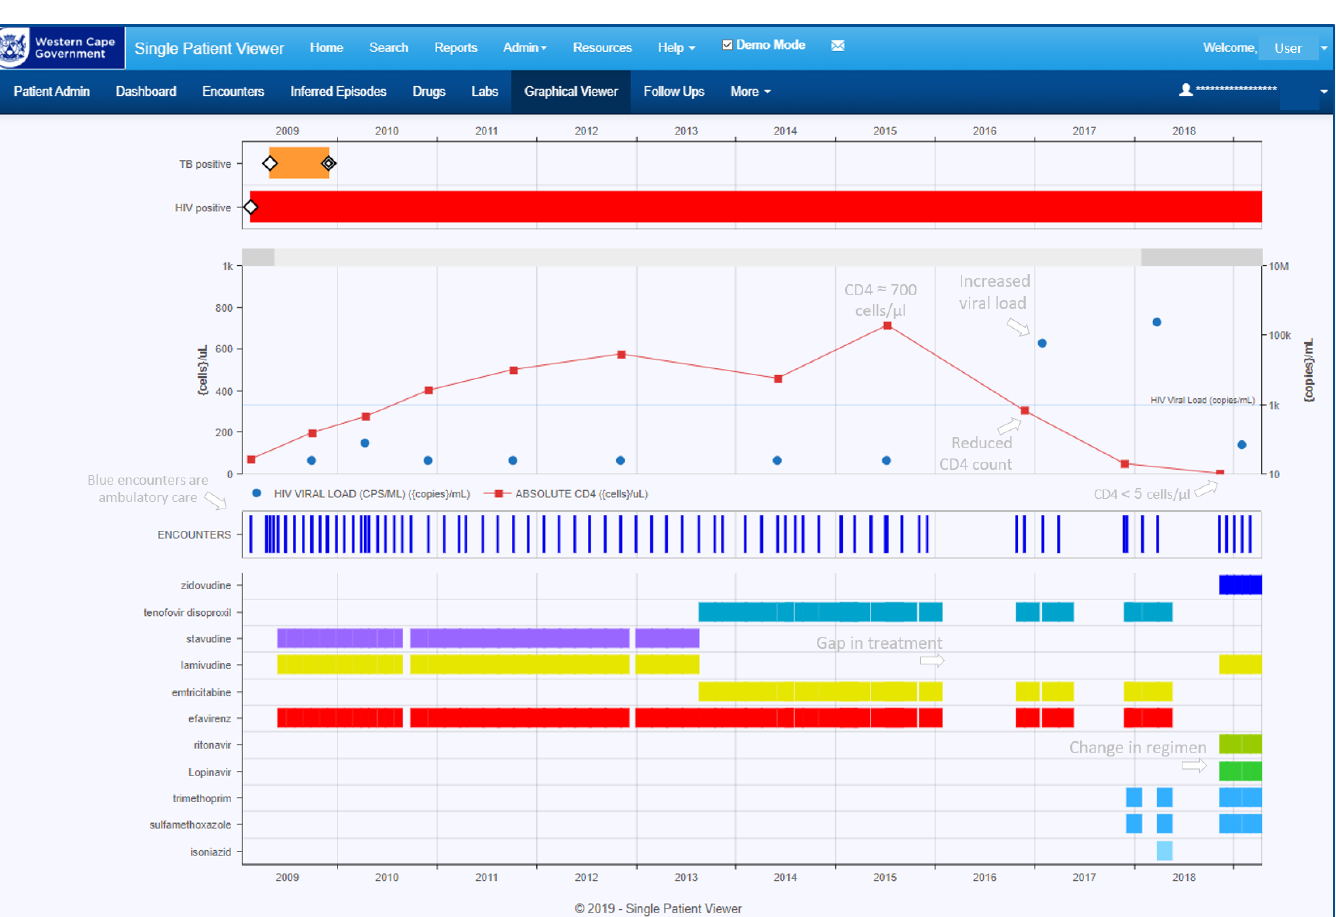
Figure 3: Web-based clinical view (“Single Patient Viewer”) graphical integration